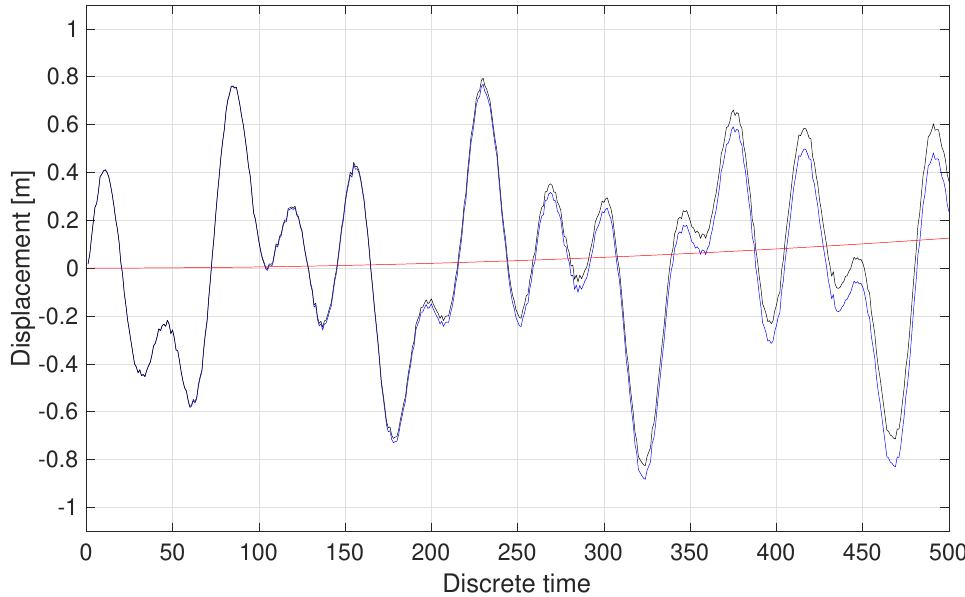
Figure 10. Displacement of a target around its rest position. The oscillations are simulated with a multi-frequency signal that is characterized by a peak value equal to 0.9 m, and 3 components at normalized frequencies equal to 0.0071, 0.0272, and 0.0146. The blue trace represents the output of the displacement sensor; the black trace is obtained by integrating the output of the acceleration sensor affected by an offset equal to 1 ppm (relative to the output range of the sensor); the red trace highlights the quadratic drift corresponding to the difference between the